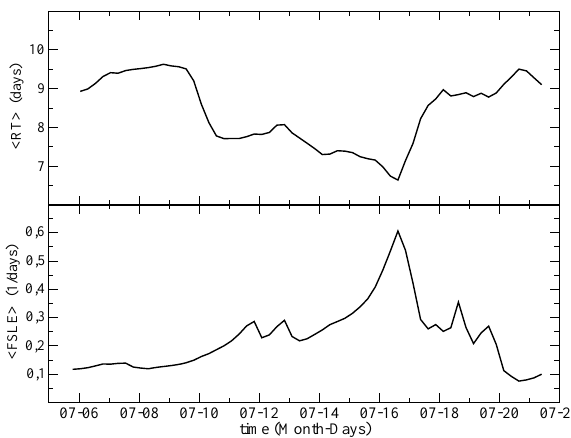
Fig. 12. Time series throughout July of (top) spatial average of resi- dence times and (bottom) spatial average of FSLE computed for the bottom